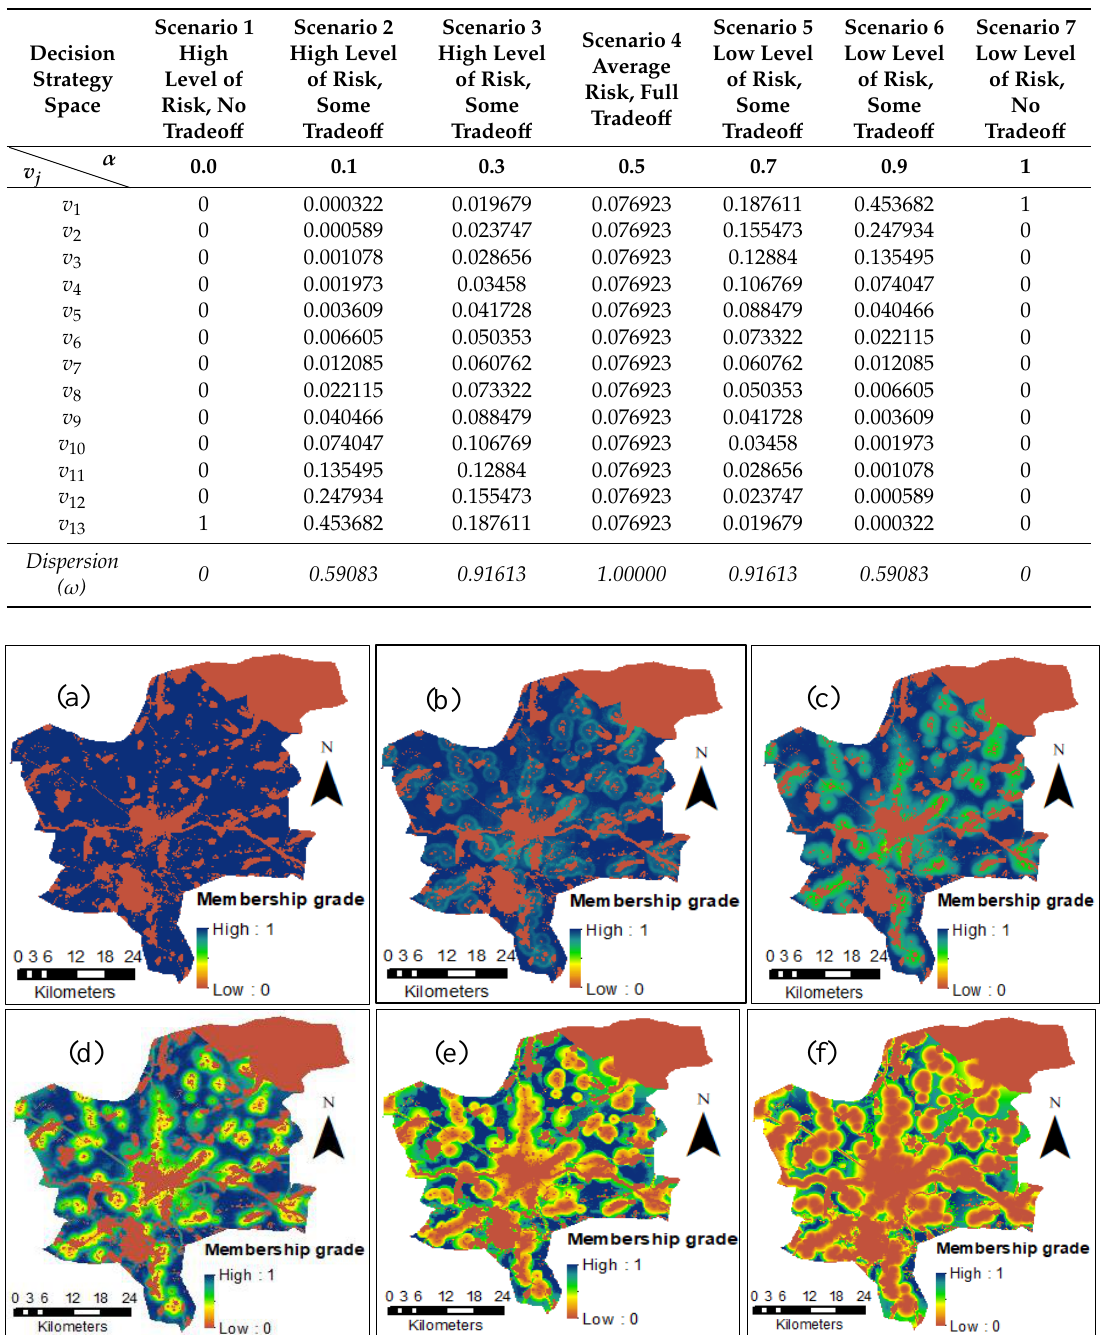
Table 5. Optimal order weights ( v j ) for selected values of α parameter for n map layers.